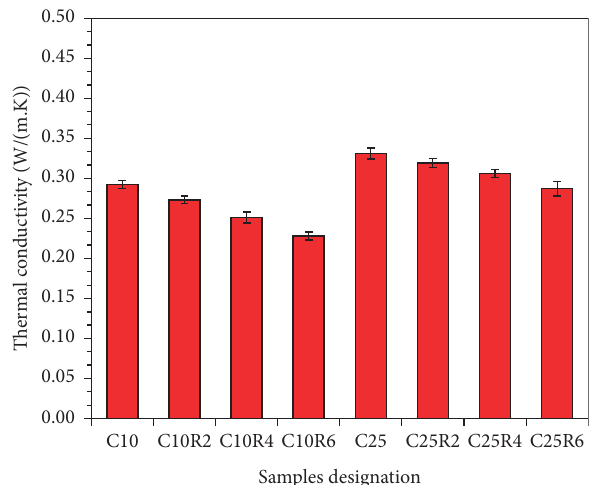
Figure 9: Values of thermal conductivity of cemented tailings